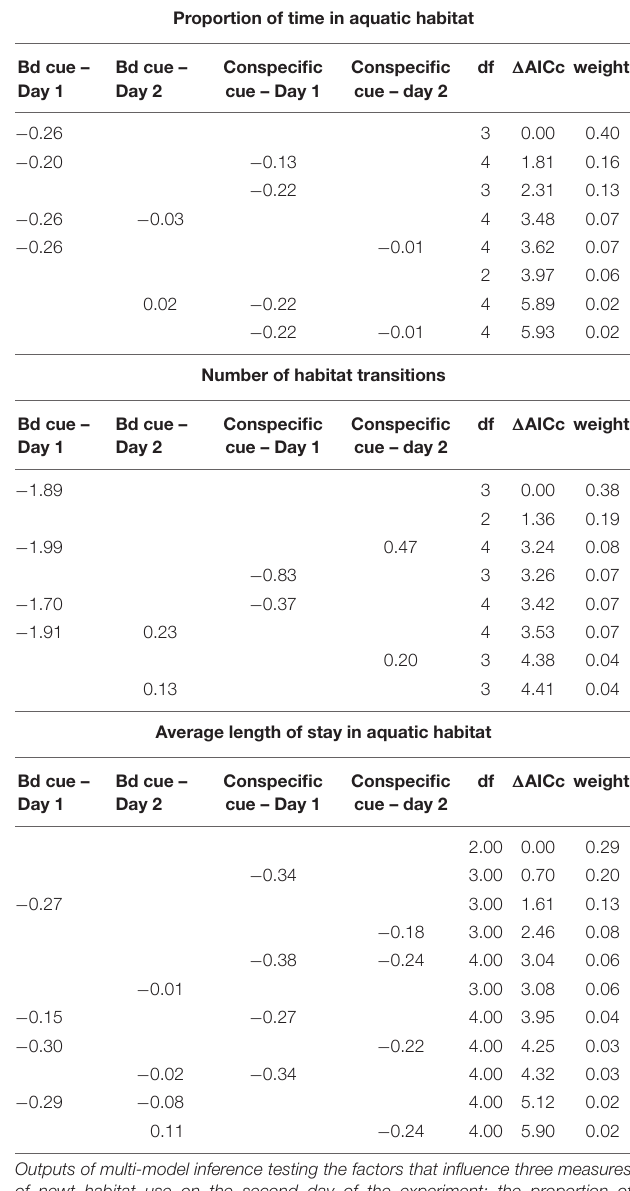
TABLE 1 | Summary statistics of the measures of newt habitat use.